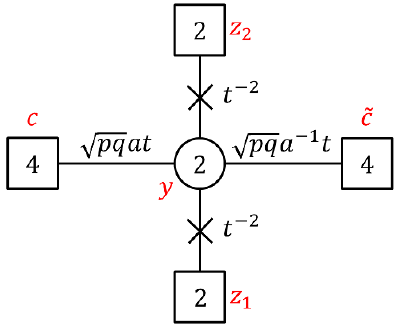
Figure 6 . A conformal Lagrangian for E-string compacti(cid:12)ed on a closed genus g surface obtained in [7]. The quiver has 2 g (cid:0) 2 SU(3) gauge nodes. The SU(9) (cid:13)avor symmetry group is a maximal subgroup of E 8 . On a submanifold of the conformal manifold the SU(9) is broken to the Cartan and the conjecture of [7] is that at some locus this becomes the Cartan of the E 8 symmetry.